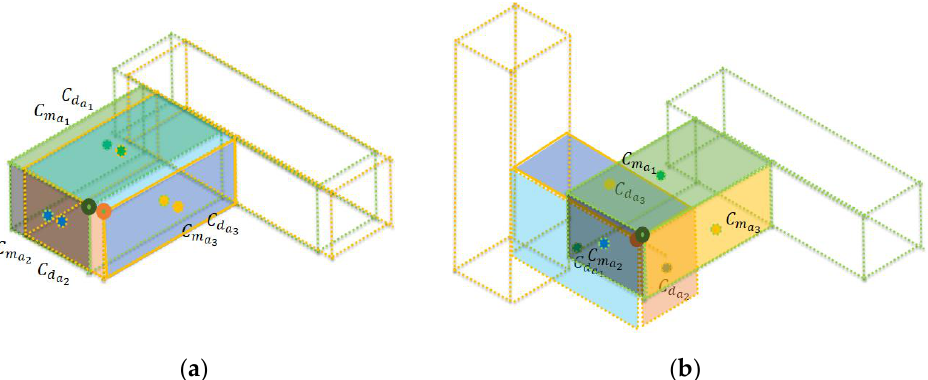
Figure 7. Visualization of as-planned model and transformed as-built model with transformations aligning the ( a ) corresponding plane segments with centroids nearest to each other and, ( b ) non- corresponding plane segments with centroids relatively far from each other.